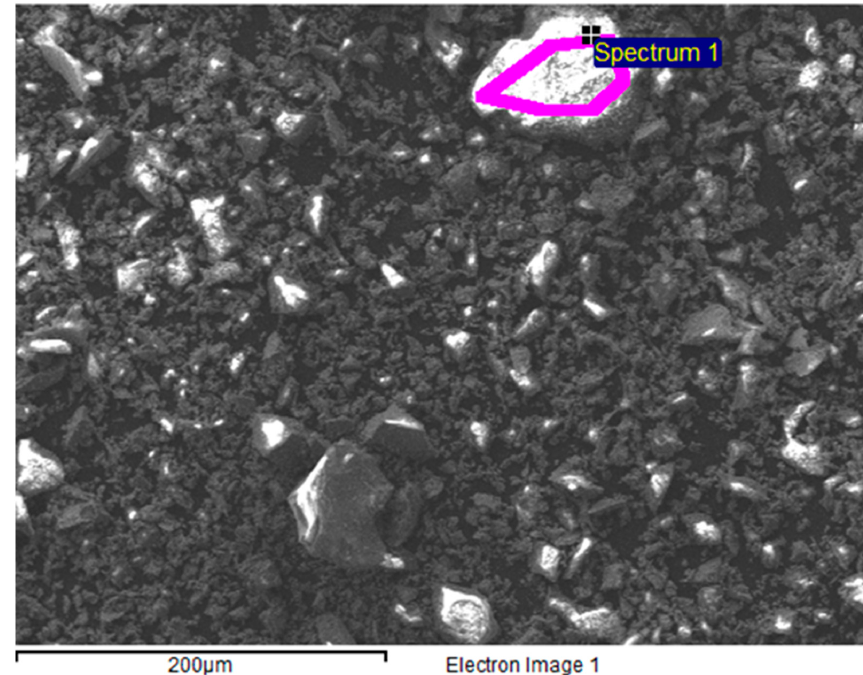
Figure 6. Cupola slag microstructure.